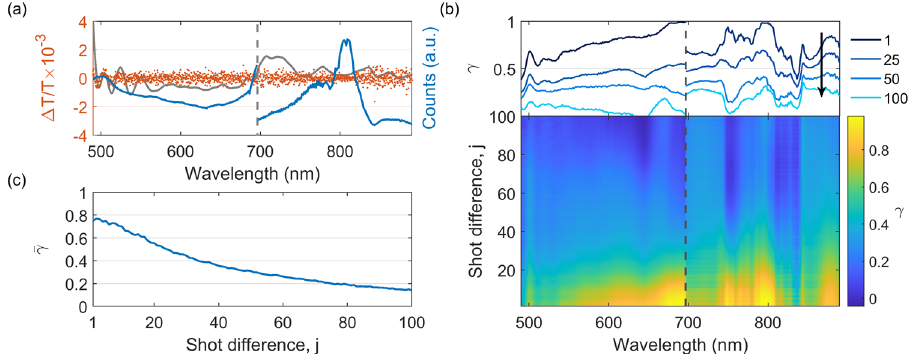
Figure 4. ( a ) Spectrum (blue) and � T / T signal (red) of 1,000 shot pairs without a sample and pump. The pseudo structures (grey) have been subtracted from the transient absorption signal. ( b ) The wavelength- dependent correlation for different shot differences, j. ( c ) Average correlation over the whole spectral